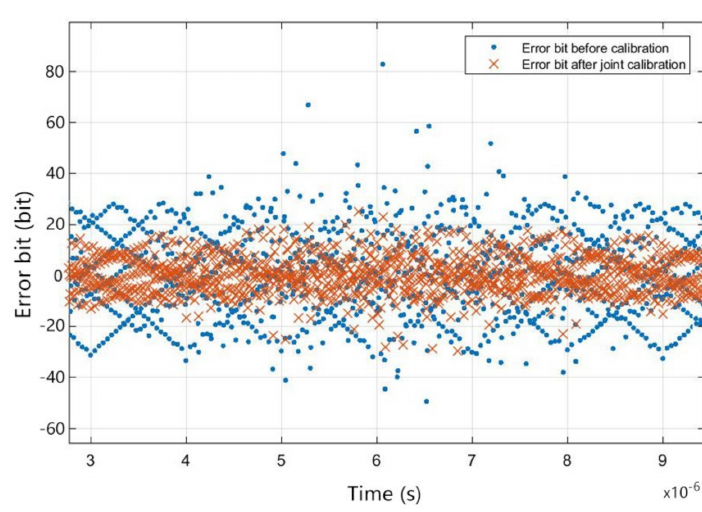
Figure 10. Time-domain output of the calibration system.